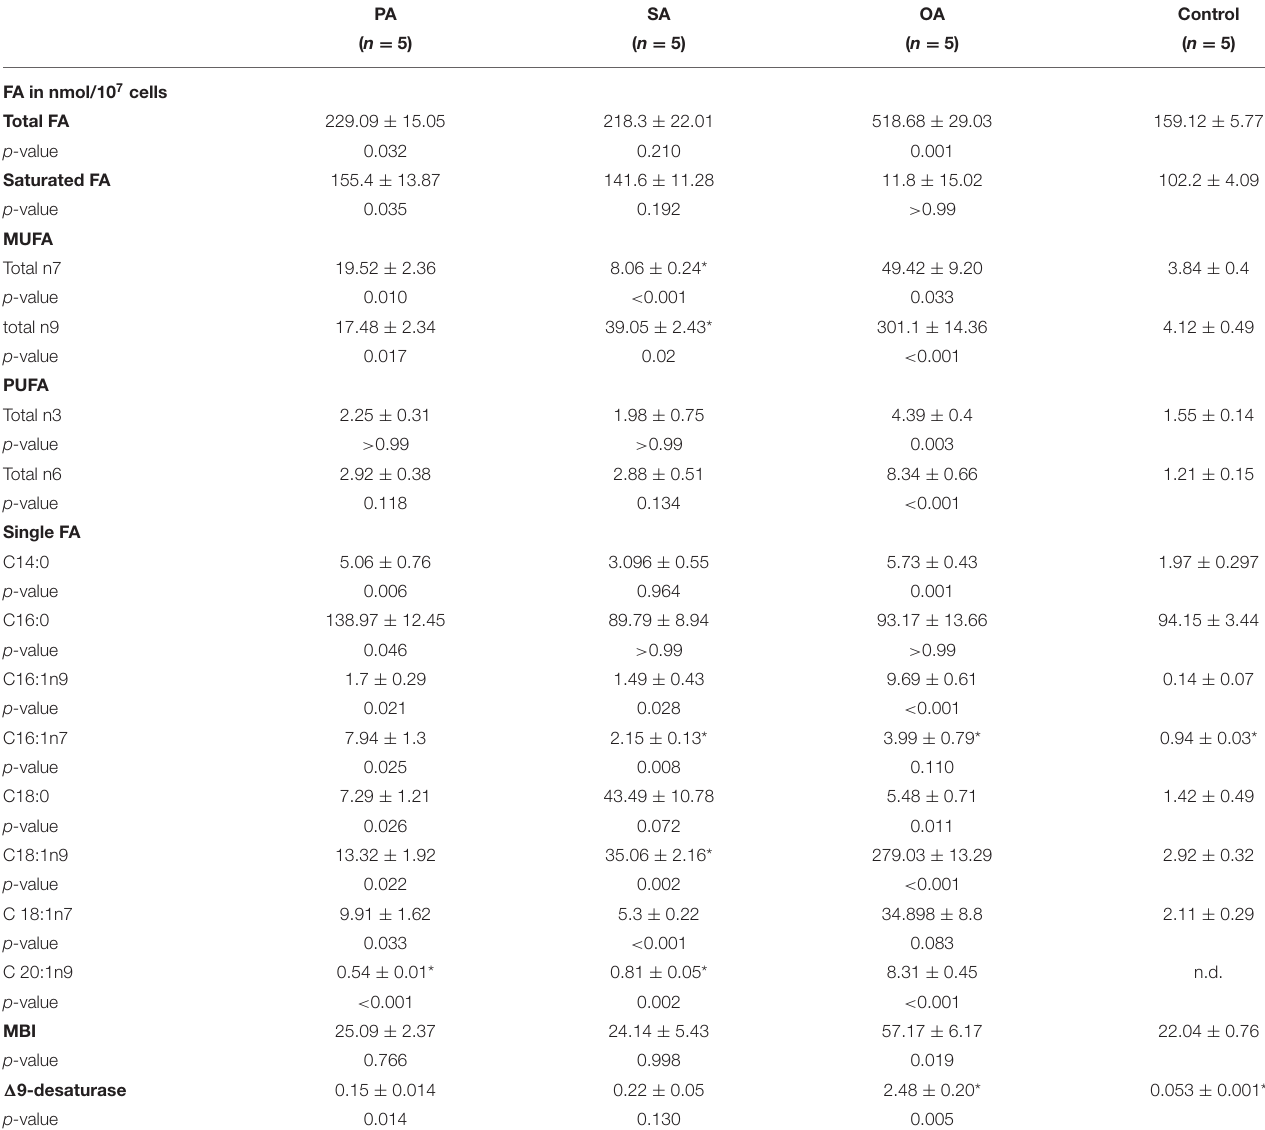
TABLE 4 | Fatty acid pattern of TAG.